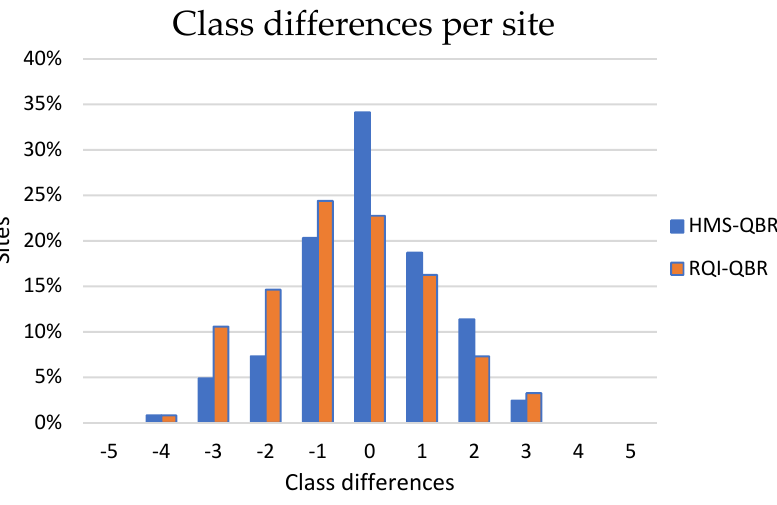
Figure 9. HMS and RQI versus QBR Classes per site.